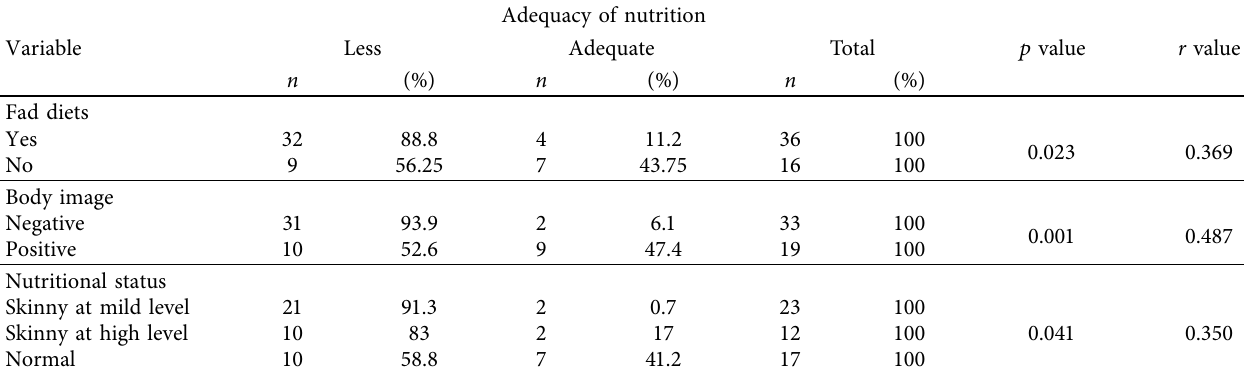
Table 6: The relation of fad diets, body image, nutritional status, and adequacy of nutrition of female models. Adequacy of Variable